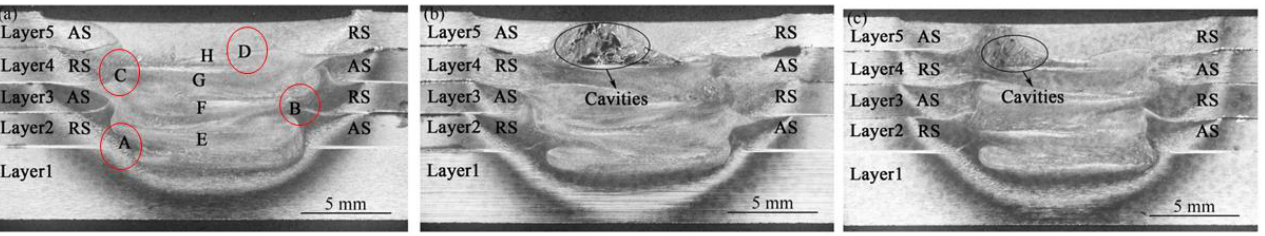
Figure 11. Al-li 2195-T8 build fabricated with single pass and flared tool pin having three concave arc grooves: ( a ) build fabricated at 800 rpm; ( b ) build fabricated at 900 rpm; ( c ) build fabricated at 1000 rpm. (reprinted from [62] with permission from Elsevier).